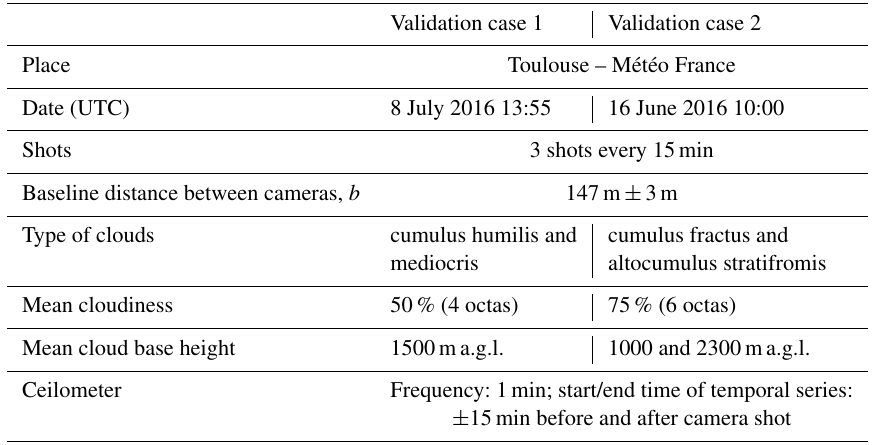
Table 3. Algorithm parameters. Undistortion/rectification algorithms Size of undistorted and rectified images: N px = 2944 Field of view of undistorted/rectified images 136 ◦ Block-matching algorithm parameters